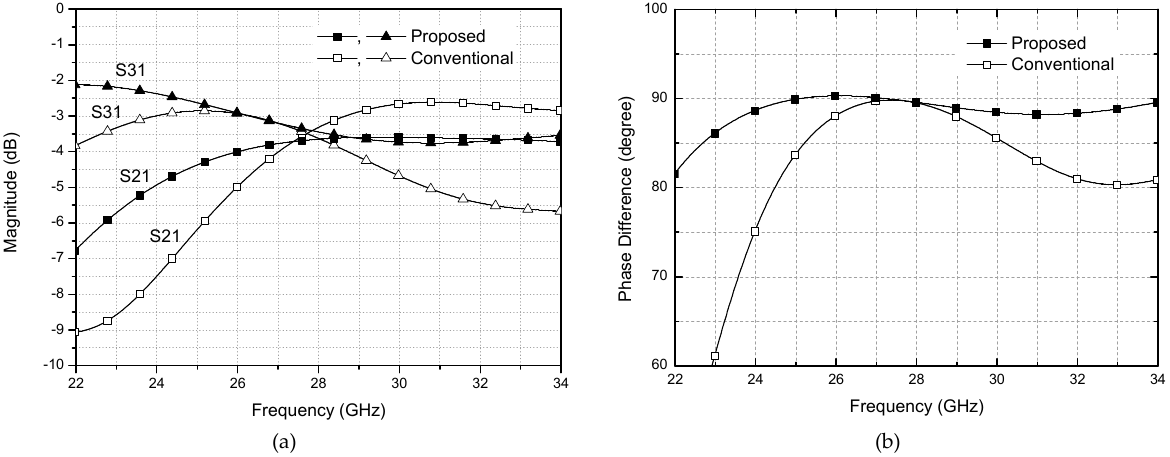
Sensors 2021 , 21 , x FOR PEER REVIEW Figure 4. Simulation comparison of the branch-line couplers. ( a ) Magnitude imbalance, ( b ) phase imbalance.